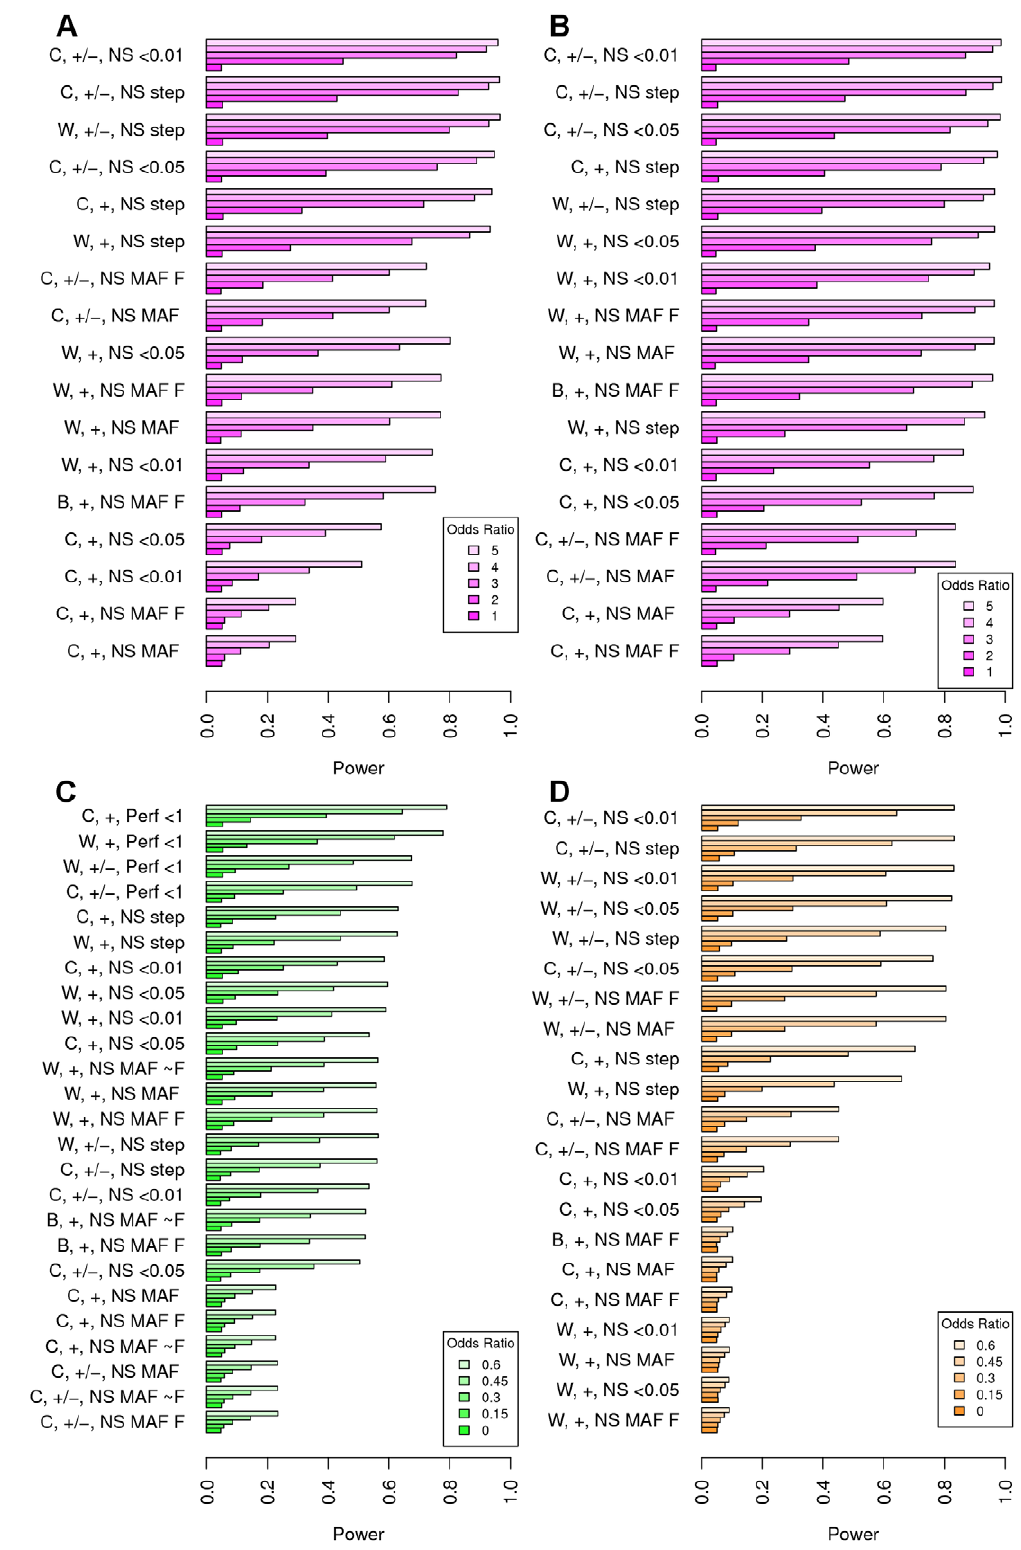
Figure 3. Further results comparing power across rare variant approaches. Results in Figures A and B show the effect of having both deleterious and protective rare variants. Figures C and D switches to a continuous trait, with Figure D showing the effect of having both deleterious and protective rare variants. Results are sorted by the plot that has the highest area, i.e., the most powerful overall. See the Figure 2 legend for additional details about the different simulations.